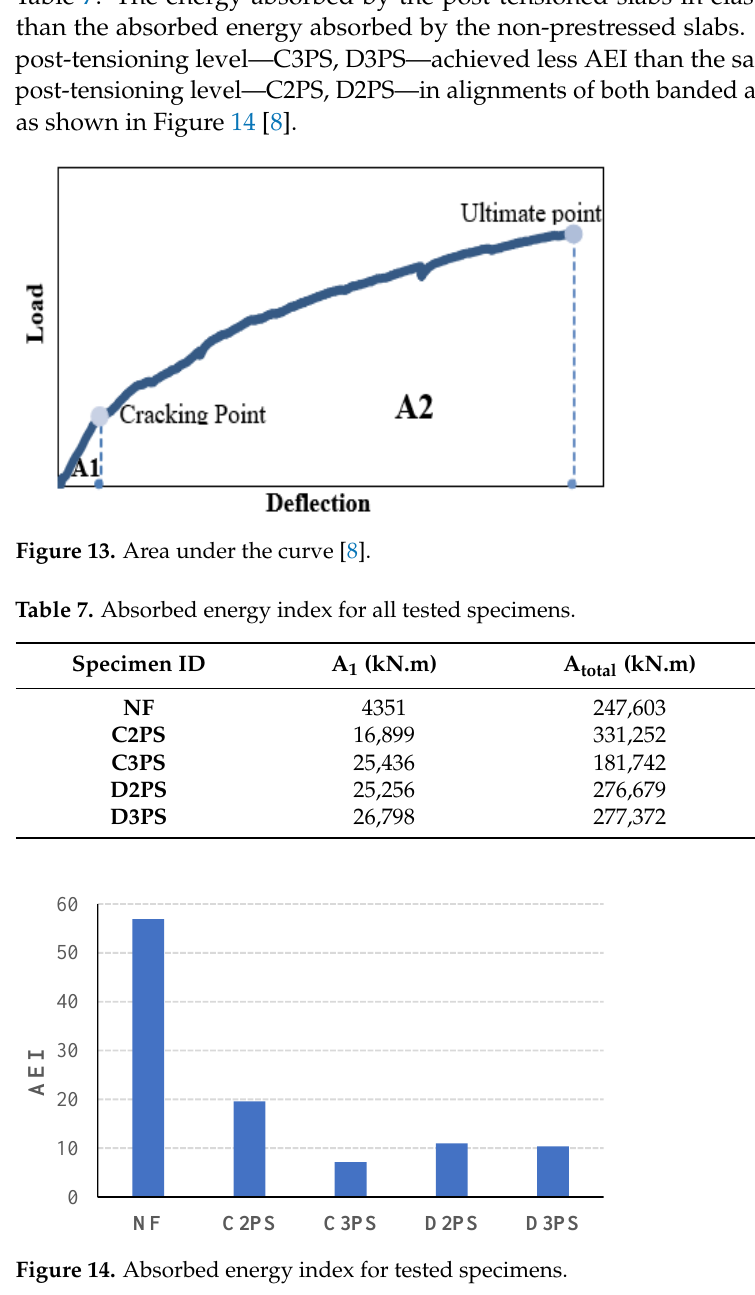
Figure 12. Ductility ratio for specimens.